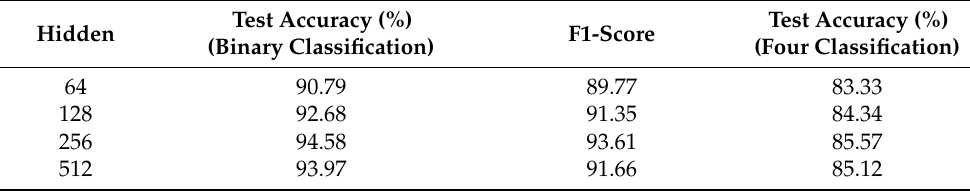
Table 5. Comparison of different LSTM hidden layer ablation